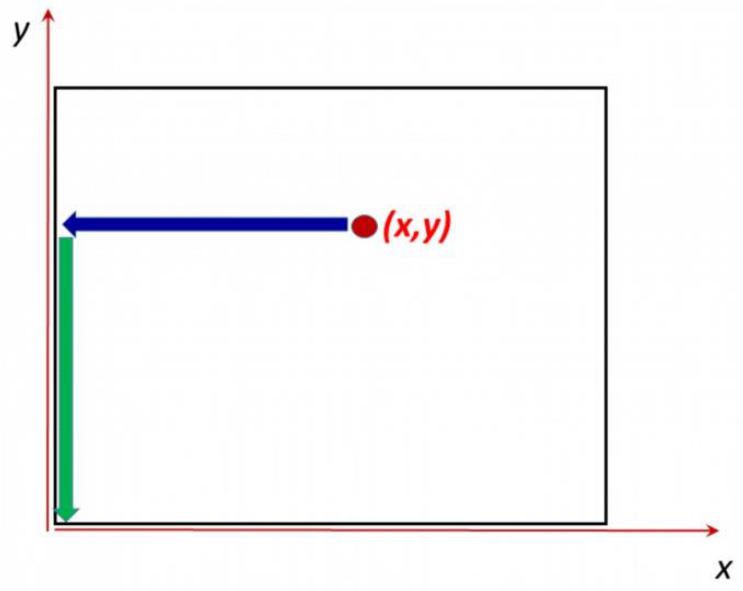
Figure 6. Schematic representation of an integration path to obtain the head h ( x , y ) at any point ( x , y ) , given the hydraulic gradient field j ( x , y ) = −∇ h ( x , y ) .